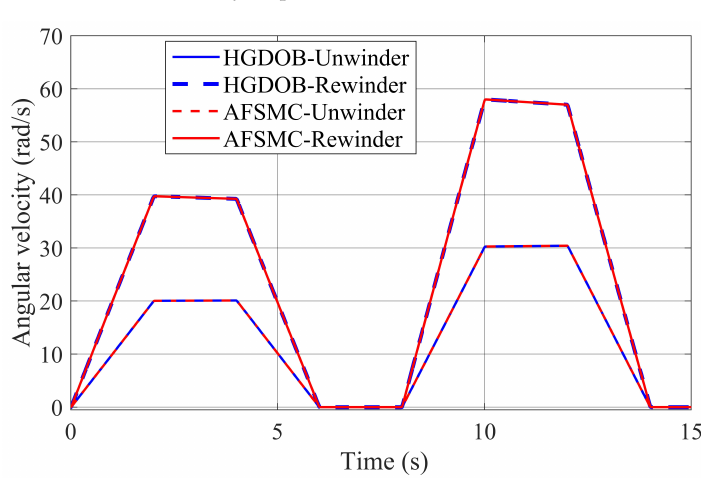
Figure 10. Axial velocity responses.